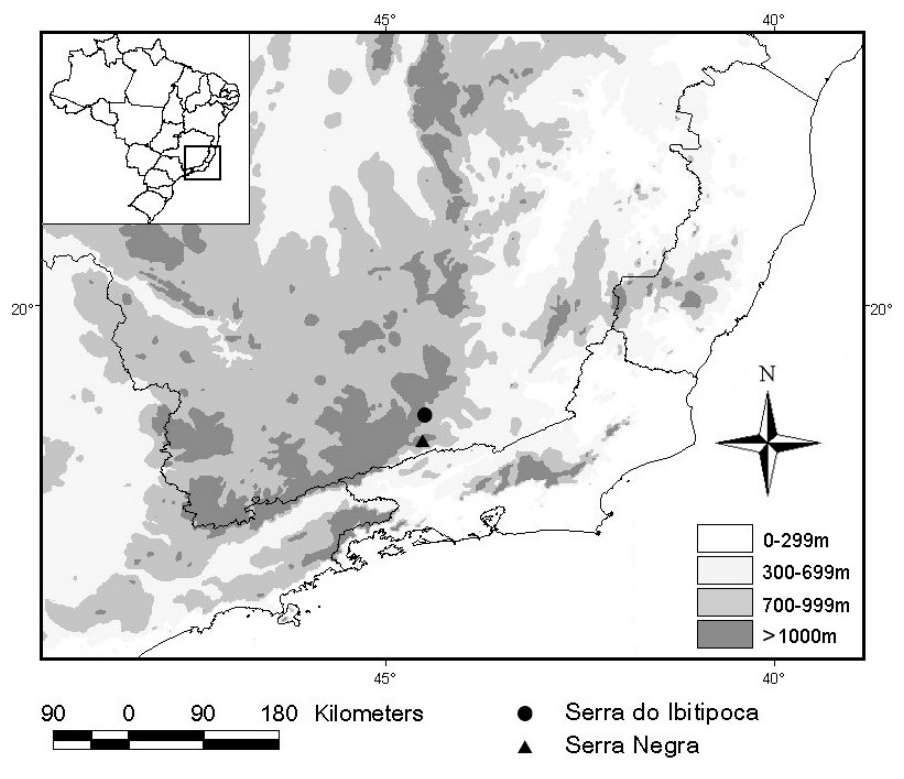
Figure 3. Distribution map of Physalaemus rupestris : Circle = Serra do Ibitipoca (type locality), municipality of Lima Duarte; Triangle = Serra Negra , municipality of Rio Preto (new record). Both records in state of Minas